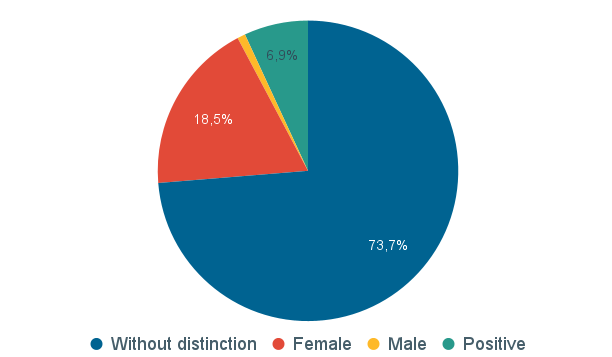
Figure 23. What did you think of the color palette? - Test 1.